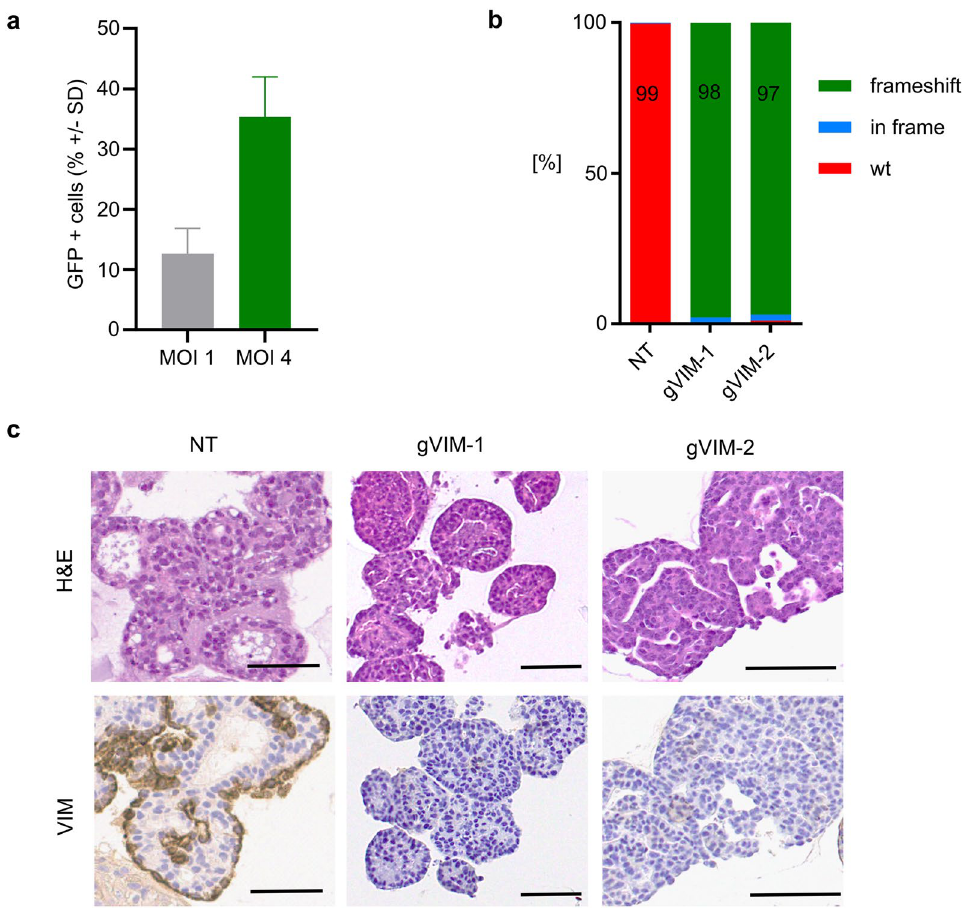
Figure 5. CMT organoids can be genetically modified with the CRISPR/Cas9 system. ( a ) GFP was introduced into ORG by lentiviral transduction at the indicated multiplicities of infection (MOI). GFP expression was analyzed by flow cytometry 3 days after transduction. For MOI 1, Mean ± SD = 12.6 ± 4.2%, for MOI 4, Mean ± SD = 35.3 ± 6.6%. Two independent experiments that were conducted with three different organoid lines are presented, demonstrating robust transduction efficiency. ( b ) Frequency of frameshift indels in organoids ORG-25-C1 modified by CRISPR/Cas9 using a gRNA targeting vimentin (gVIM-1 and gVIM-2), compared to the non-targeting (NT) gRNA. TIDE analysis two passages after transduction. ( c ) Representative images of H&E stainings and immunohistochemistry of VIM in organoids ORG-25-C1 modified by CRISPR/Cas9 using a gRNA targeting vimentin (gVIM-1 and gVIM-2), compared to the non-targeting (NT) gRNA. Embedding four passages after transduction. Scale bar, 50